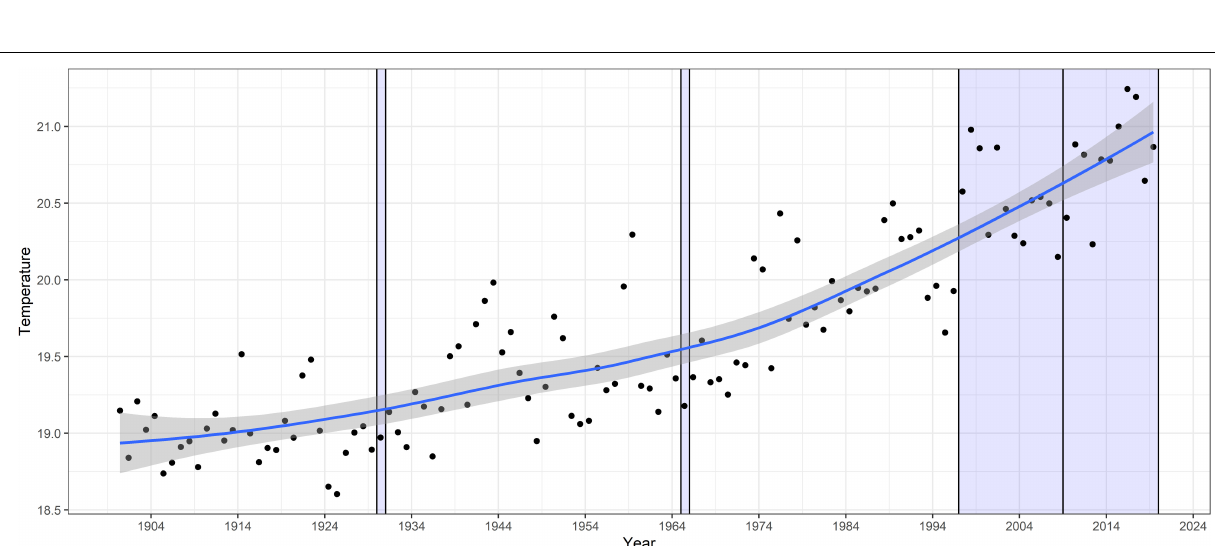
Frontiers in Marine Science |